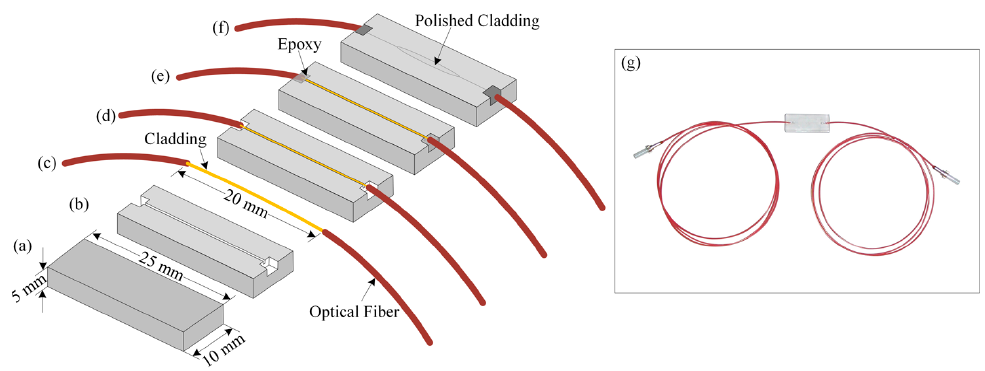
Figure 2. Step-by-step fabrication procedure of the side-polished fiber-optic device: ( a ) Quartz block; ( b ) Creating the V-groove on the quartz block; ( c ) Removing the jacket of the optical fiber; ( d ) Bending the removed-jacketed-portion of the optical fiber and placing it into the V-groove of the quartz block; ( e ) Using epoxy; ( f ) Polishing the fiber-optic quartz block; and ( g ) A photograph of the fabricated side-polished fiber-optic device.